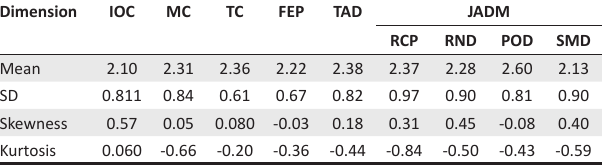
TABLE 4: Descriptive statistics of employment equity dimensions ( N =